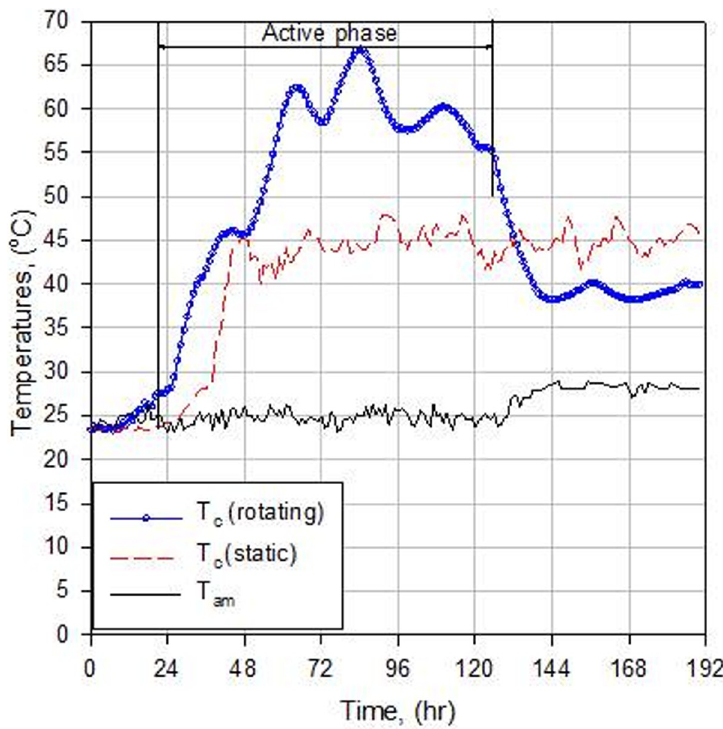
Fig 5. Time course of compost temperatures measured in the rotating and static bioreactors ( T c ) and for the ambient air ( T am ) during the composting